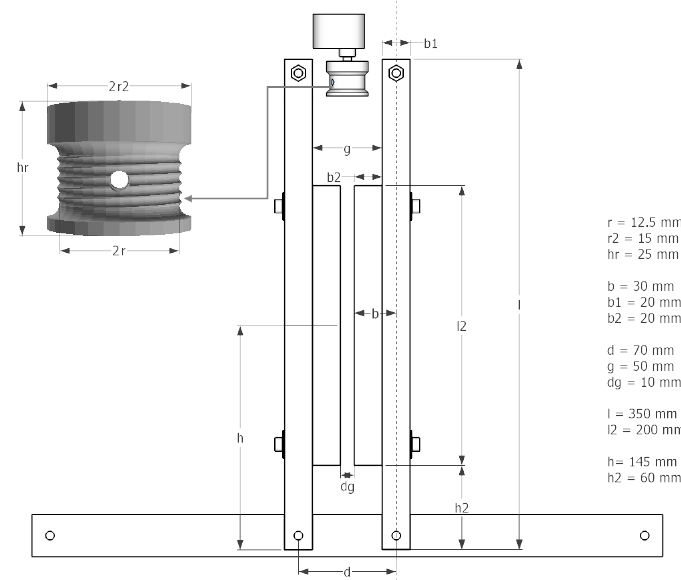
Figure 16. Schematic of the eARM system with arms in the maximum compression position. The design will require